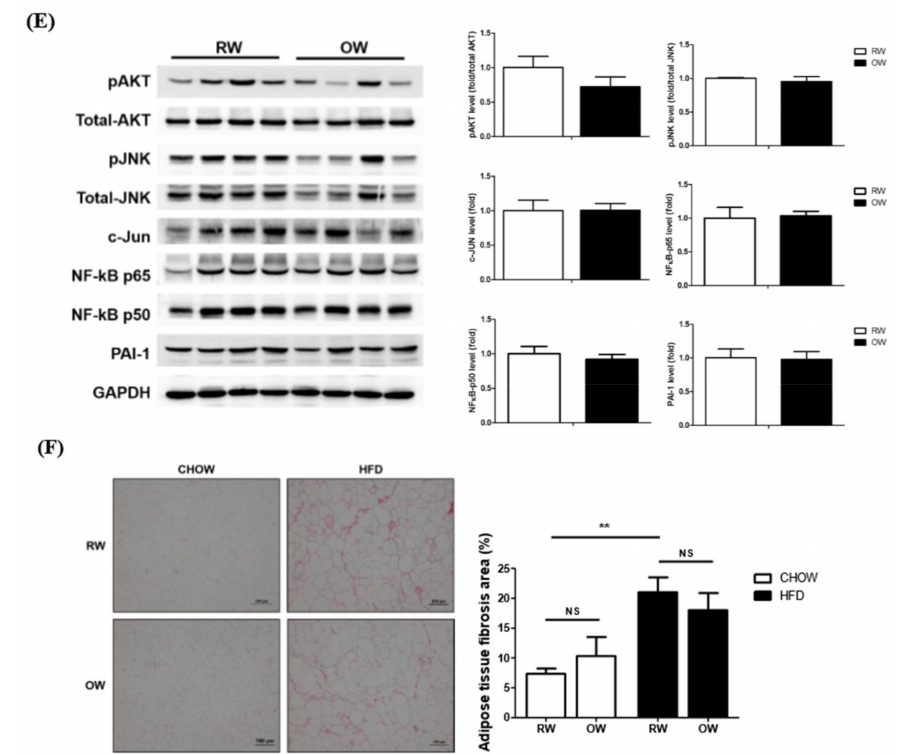
Figure 6. Effects of long-term oxygenated water consumption on muscle and adipose tissues. C57BL / 6J mice were fed with CHOW or HFD and either OW or RW as drinking water. ( A ) Weights of epididymal white adipose tissue (eWAT) were measured at the end of study period. ( B ) Representative results of eWAT H&E staining. Number of adipocytes were calculated and presented as number of cells / high power field (400 × ), scale bar: 100 µ m. ( C , D ) Levels of pro-inflammatory molecules protein and pAKT in eWAT ( C ) and muscle ( D ) of CHOW and HFD mice were analyzed and quantified. ( E ) Levels of pro-inflammatory molecules protein and pAKT in eWAT were analyzed. ( F ) Collagen accumulation in eWAT were determined by sirius red (SR) stain, scale bar: 100 µ m. Degree of fibrosis was semi-quantified by MetaMorph software. Data were presented as mean ± S.E.M ( n = 5), and statistically analyzed by two-tail unpaired Student t -test, * p < 0.05, ** p < 0.005, *** p < 0.001, NS: no